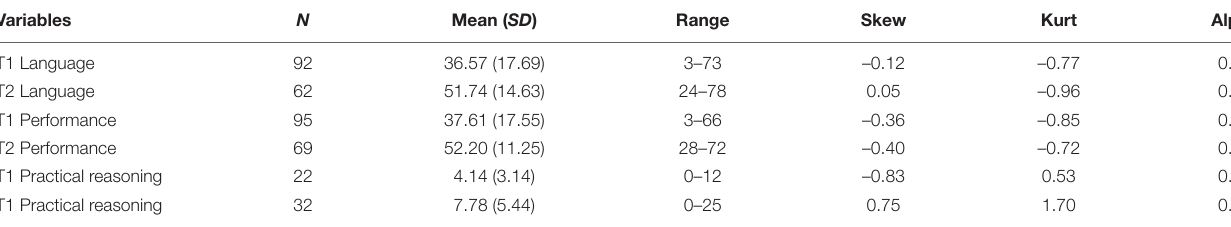
TABLE 2 | Griffiths Mental Development Scales (GMDS) scores at T1 and T2.